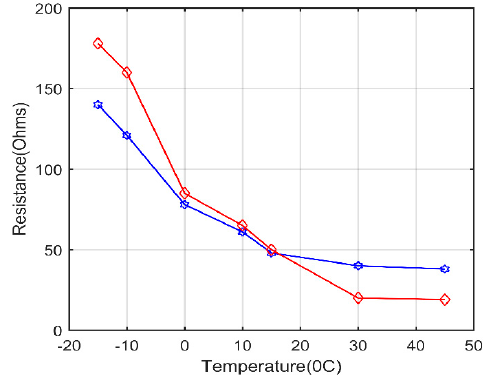
Figure 14. Relationship of temperature and resistance.